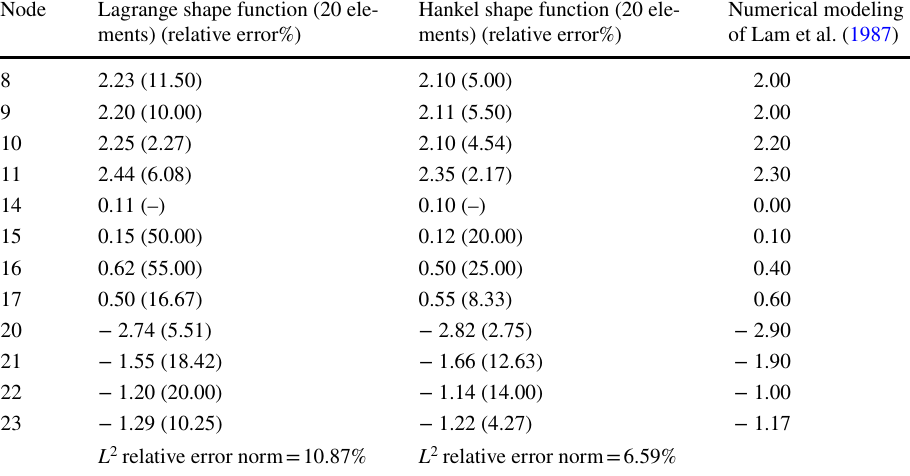
Node Lagrange shape function (20 ele- ments) (relative error%)